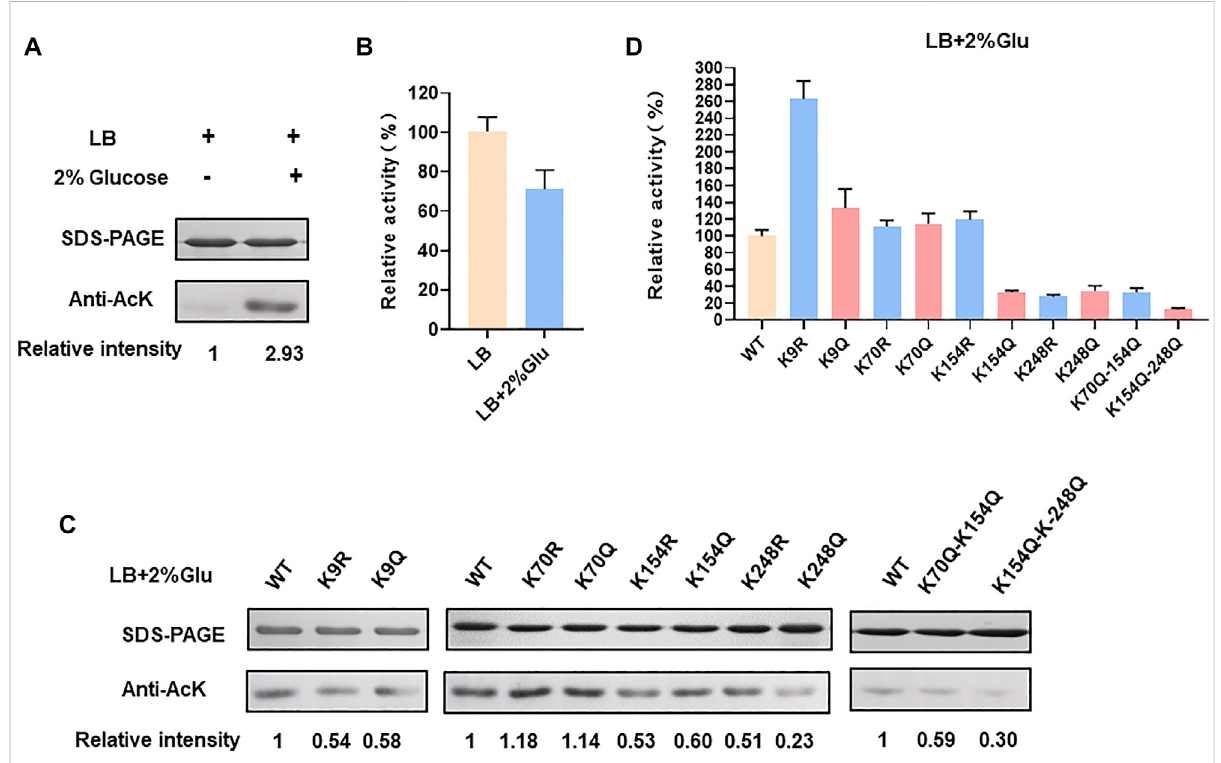
FIGURE 1 LdhA acetylation and enzyme activity in LB with 2% glucose cultivated condition. (A) SDS-PAGE and western blot analysis of LdhA cultivated in different conditions. (B) LdhA activity in cells grown in LB broth with and without 2% glucose supplementation. (C) SDS-PAGE and western blot analysis of LdhA variants with lysine substitution. (D) The enzyme activities of LdhA variants with lysine substitution.